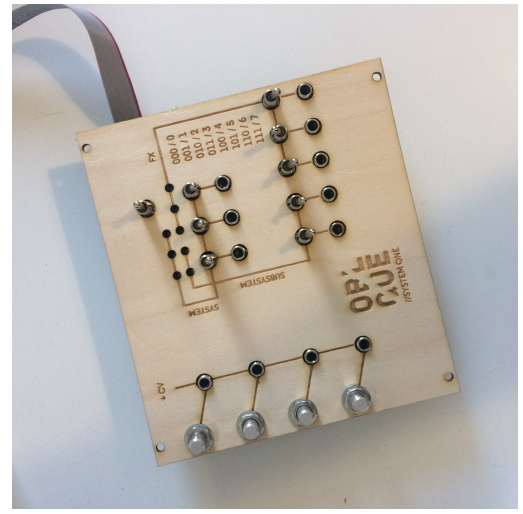
Figure 1. The Front Panel of the Prototype